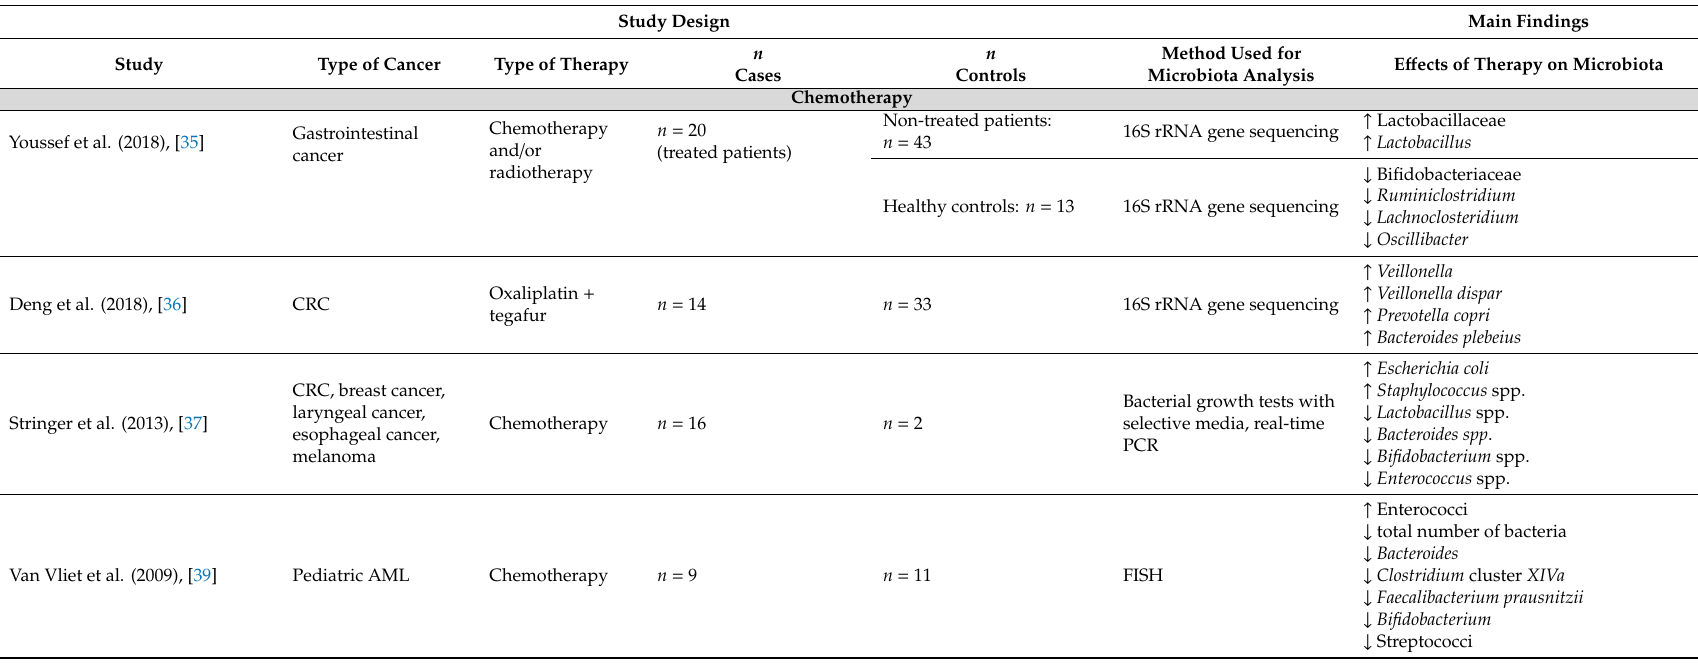
Table 3. Clinical studies assessing intestinal microbiota changes during systemic cancer therapy by cross-sectional